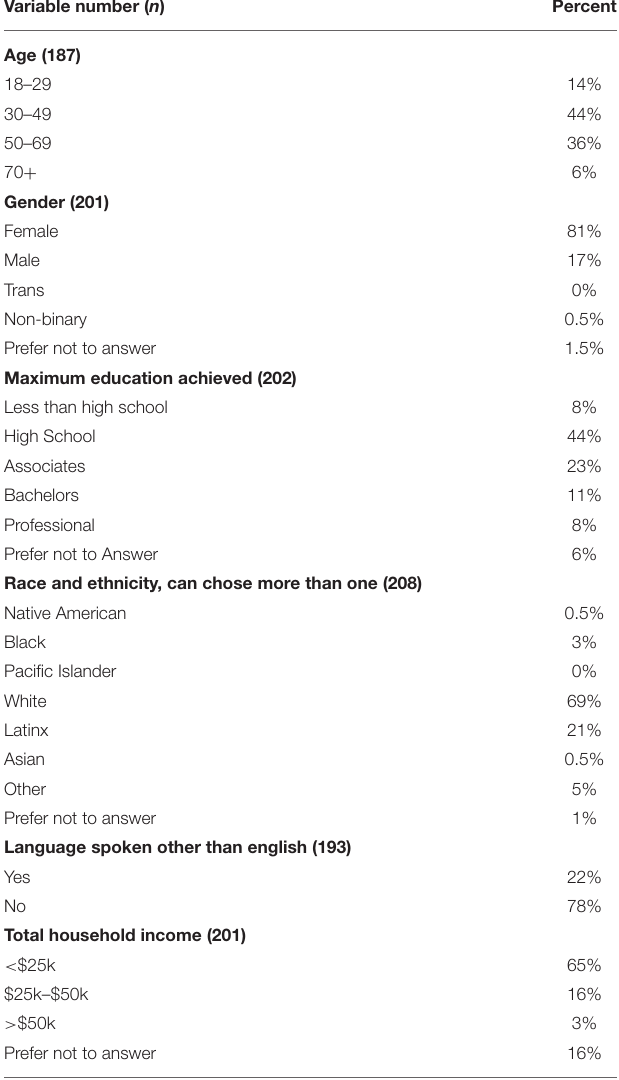
TABLE 2 | Survey responses from 205 clients of low-cost veterinary clinic in Worcester, MA regarding factors affecting access to veterinary care pre-pandemic and during the pandemic (can answer more than